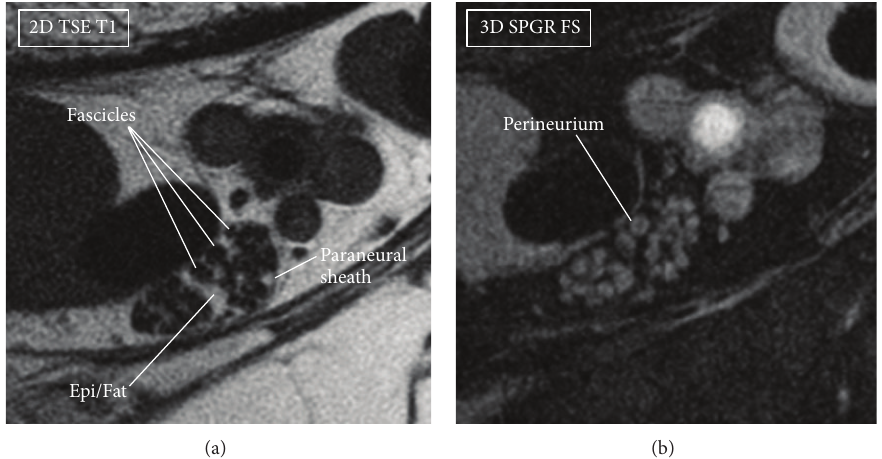
Figure 4: Tibial nerve, axial sections. In 2D TSE T1 weighted image (a) the fascicles are hypointense surrounded by a hyperintense tissue, mainly the epineurial fat (Epi/Fat), while the fibrous part of the epineurium has low signal and surrounds the fascicles; it is not clearly seen. The paraneural sheath is also detected. In SPGR fat suppressed image (b), the fascicles are covered by a bright thin layer, the perineurium, best seen when the acquisition plane is exactly perpendicular to the nerve orientation, therefore minimizing the partial volume